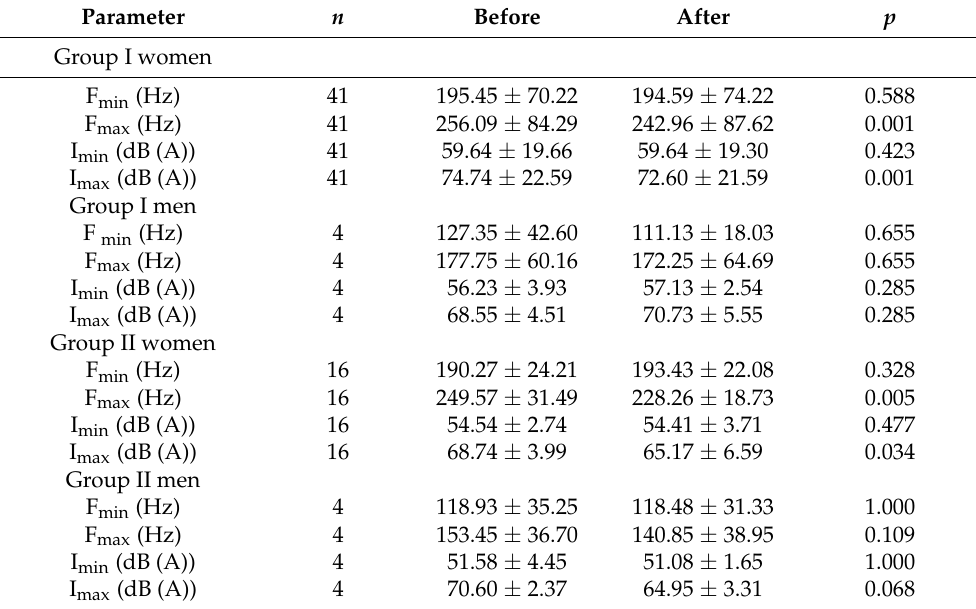
Table 1. SRP: mean values, standard deviations, statistical significance.